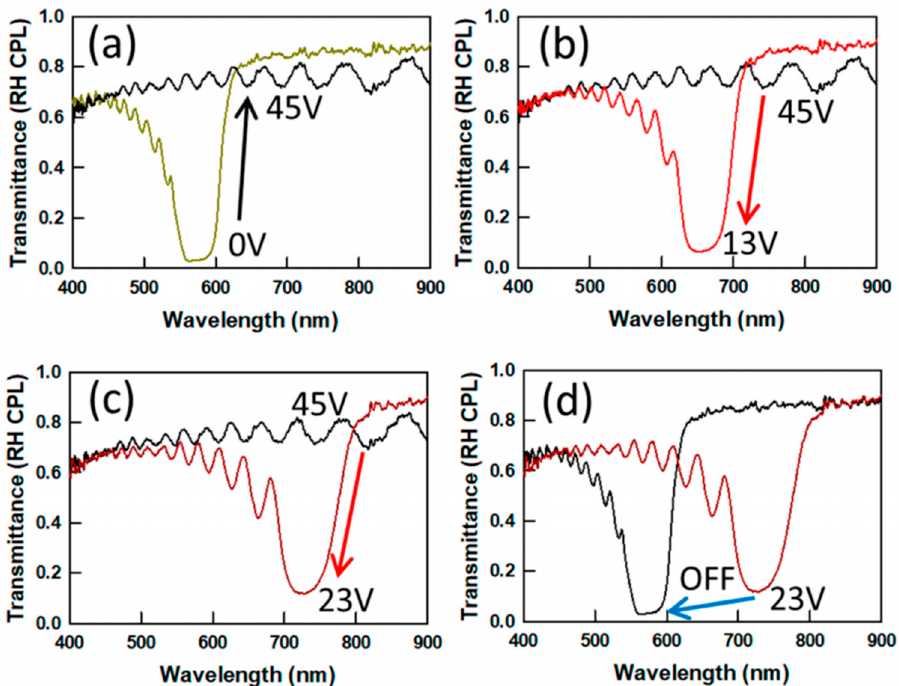
Figure 7. Transmission spectra of a negative ∆ ε PSCLC with 5 ± 0.2 µ m thickness showing a ( a ) reflective to transparent or ( b , c ) transparent to reflective switching response by application of a DC voltage. ( d ) Spectra for the relaxation to the off state from 23 V DC. Adapted from ref. [50].